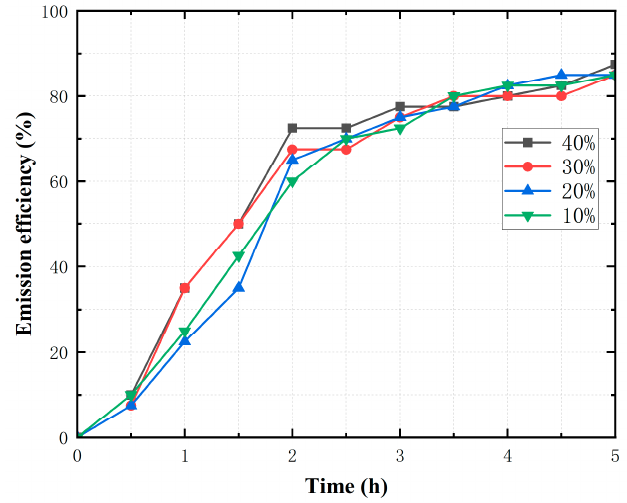
Figure 11. Emission curves under different conditions.